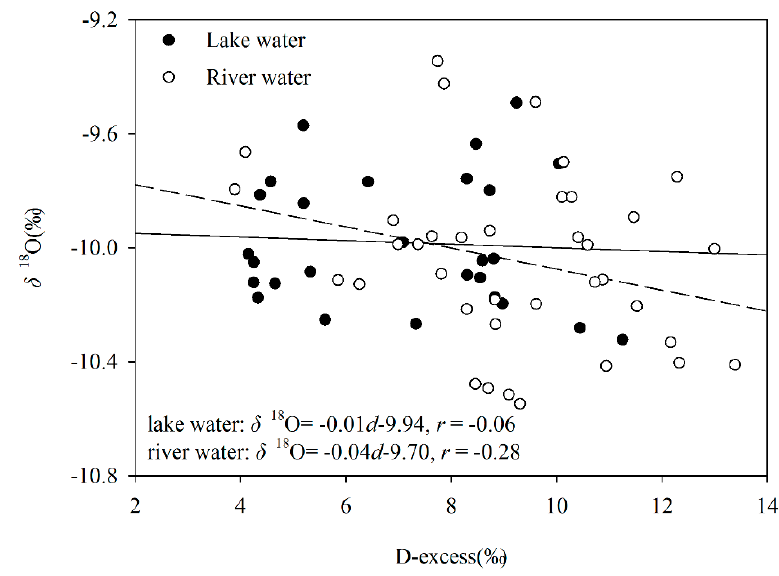
Figure 5. Correlation between D-excess and δ 18 O in the lake and river waters. The dashed line denotes the linear fit of lake water and the solid line denotes the linear fit of the river water.